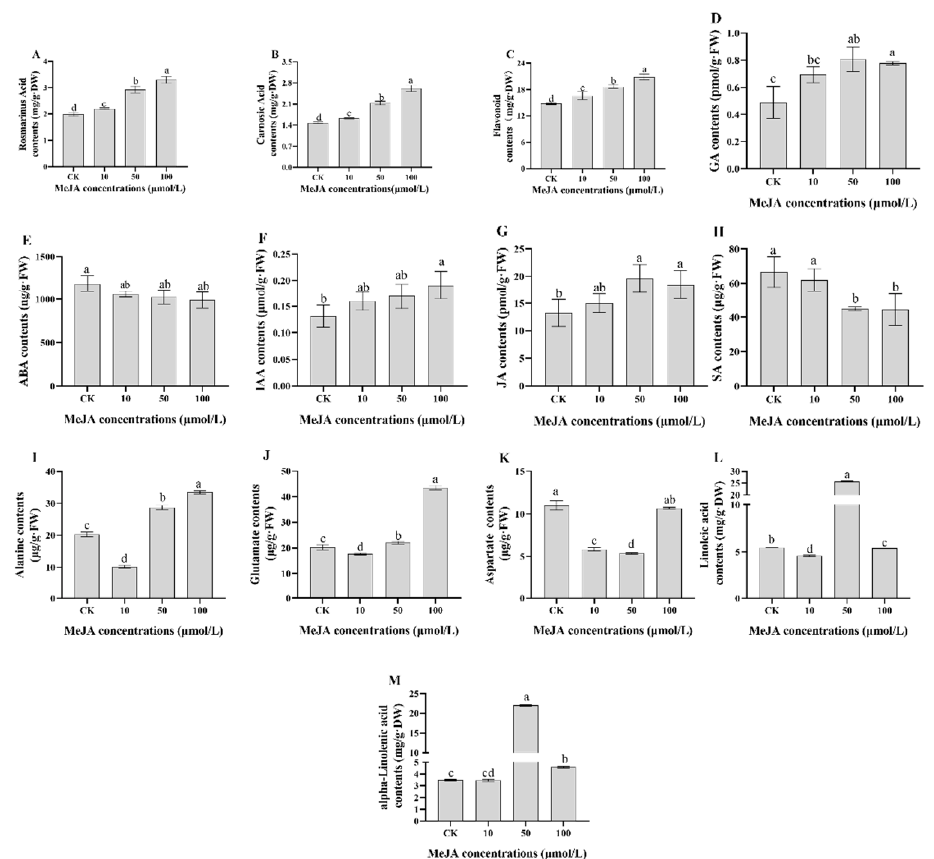
Figure 1. Content of physiological and biochemical indicators in rosemary suspension cells under different concentrations of MeJA for 48 h. ( A ) rosmarinic acid (mg RA/g DW); ( B ) carnosic acid (mg CA/g DW); ( C ), flavonoids (mg flavonoids/g DW); ( D ) gibberellin (pmol GA/g FW); ( E ), abscisic acid (ng ABA/g FW); ( F ) auxin ( μ mol IAA/g FW); ( G ) jasmonate (pmol JA /g FW); ( H ) salicylic acid ( μ g SA/g FW); ( I ) alanine ( μ g Ala/g FW); ( J) glutamate ( μ g Glu/g FW); ( K ) aspartate ( μ g Asp/g FW); ( L ) linoleic acid (mg/g DW); ( M ) alpha-linolenic acid (mg/g DW). Different letters above the bars respectively indicate a significant difference ( p < 0.05) from CK (0) among the CK and MeJA treatment groups. Error bars represent SDs ( n =